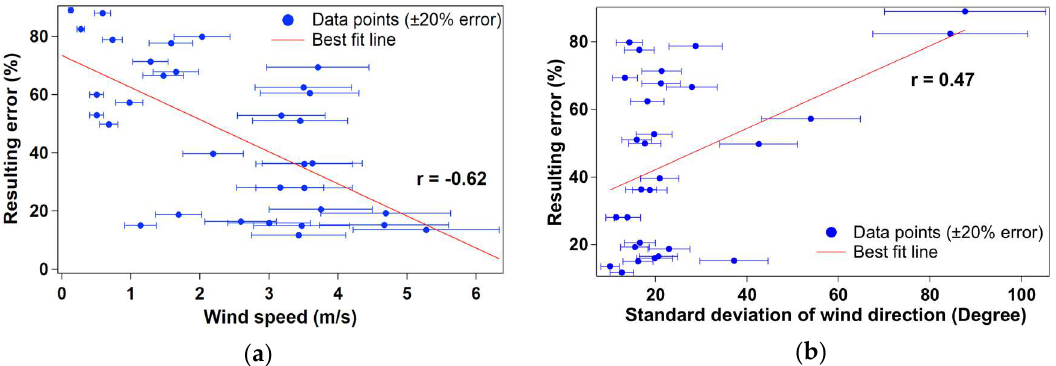
Figure 10. ( a ) Resulting error of leak rate versus wind speed. ( b ) Resulting error versus standard deviation of wind direction.